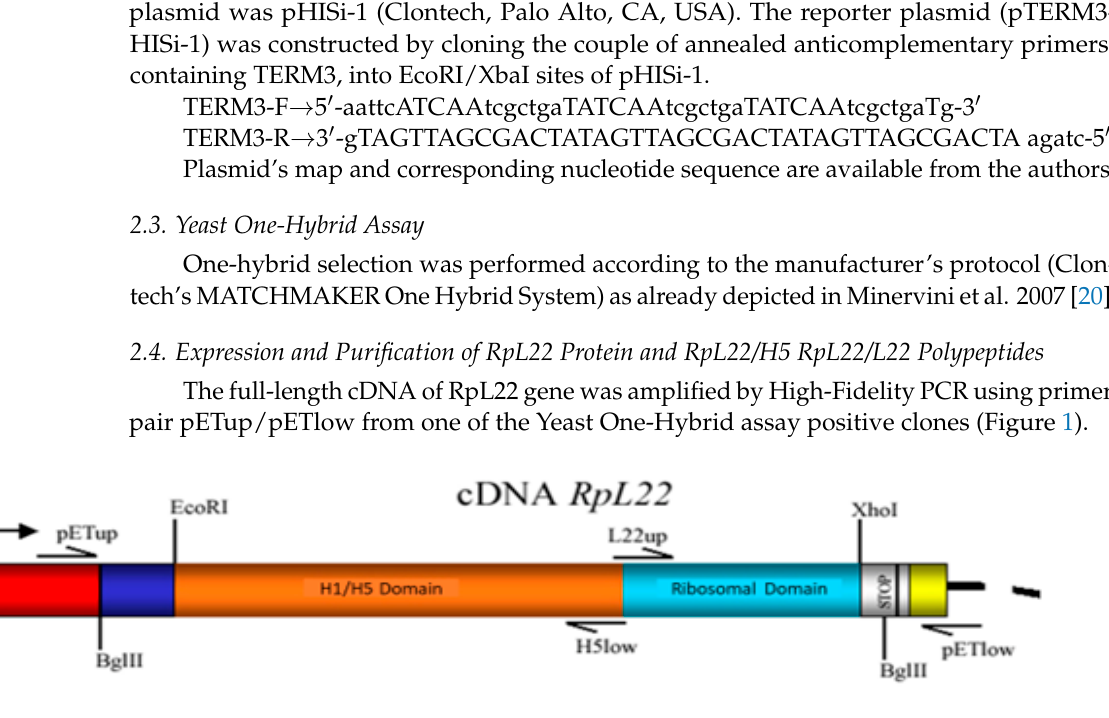
Figure 1. Full-length RpL22 cDNA clone. Graphical representation of the RpL22 cDNA clone which was used to construct vectors expressing RpL22 and its sub-domains (ribosomal and histone-like). Arrows indicate the name and position of the PCR